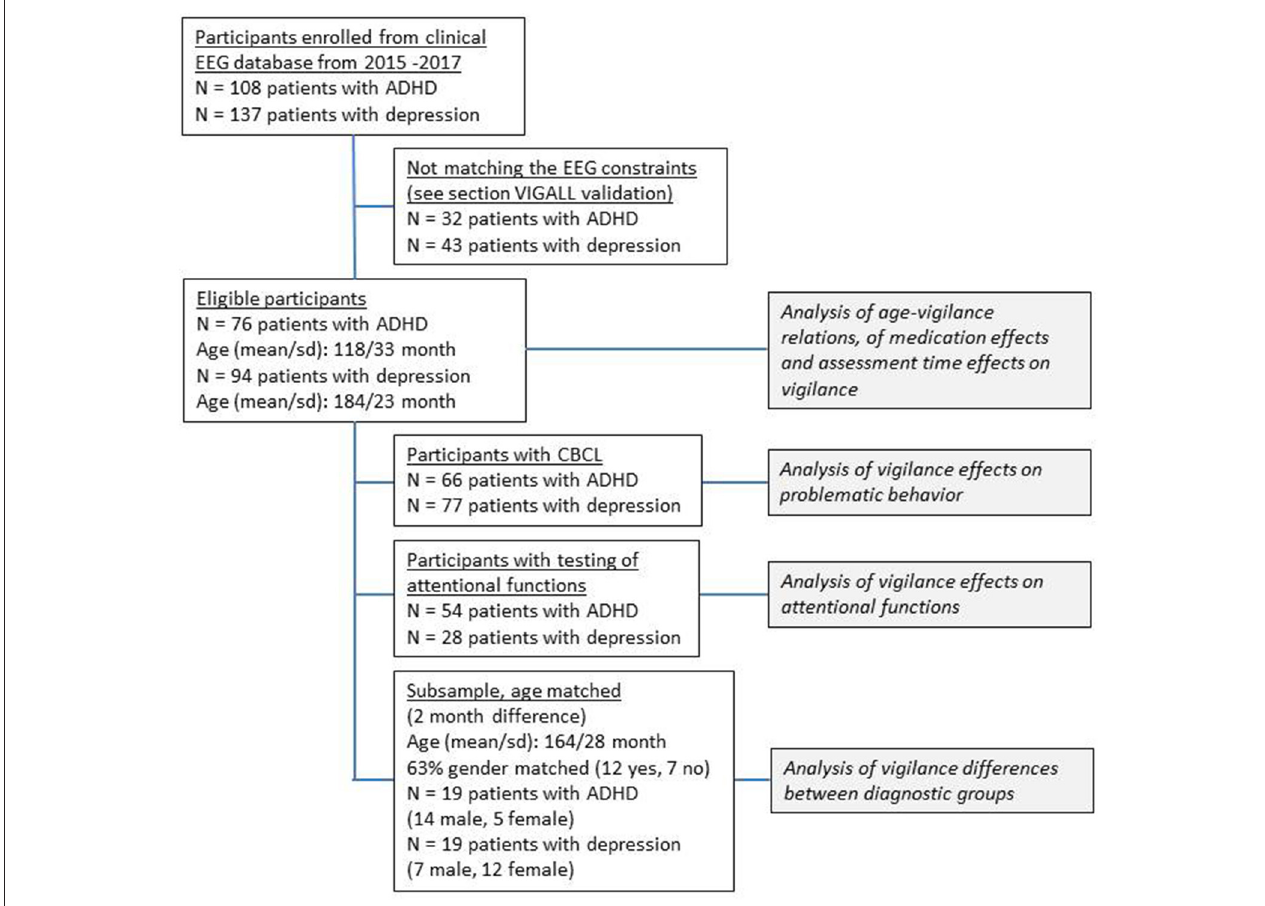
FIGURE 1 | Study design flow chart. This is a sketch of the study design; in order to maximize the number of participants, we analyzed the effect of the covariates age, medication, and time of assessment on the EEG vigilance in the first subsample of all eligible